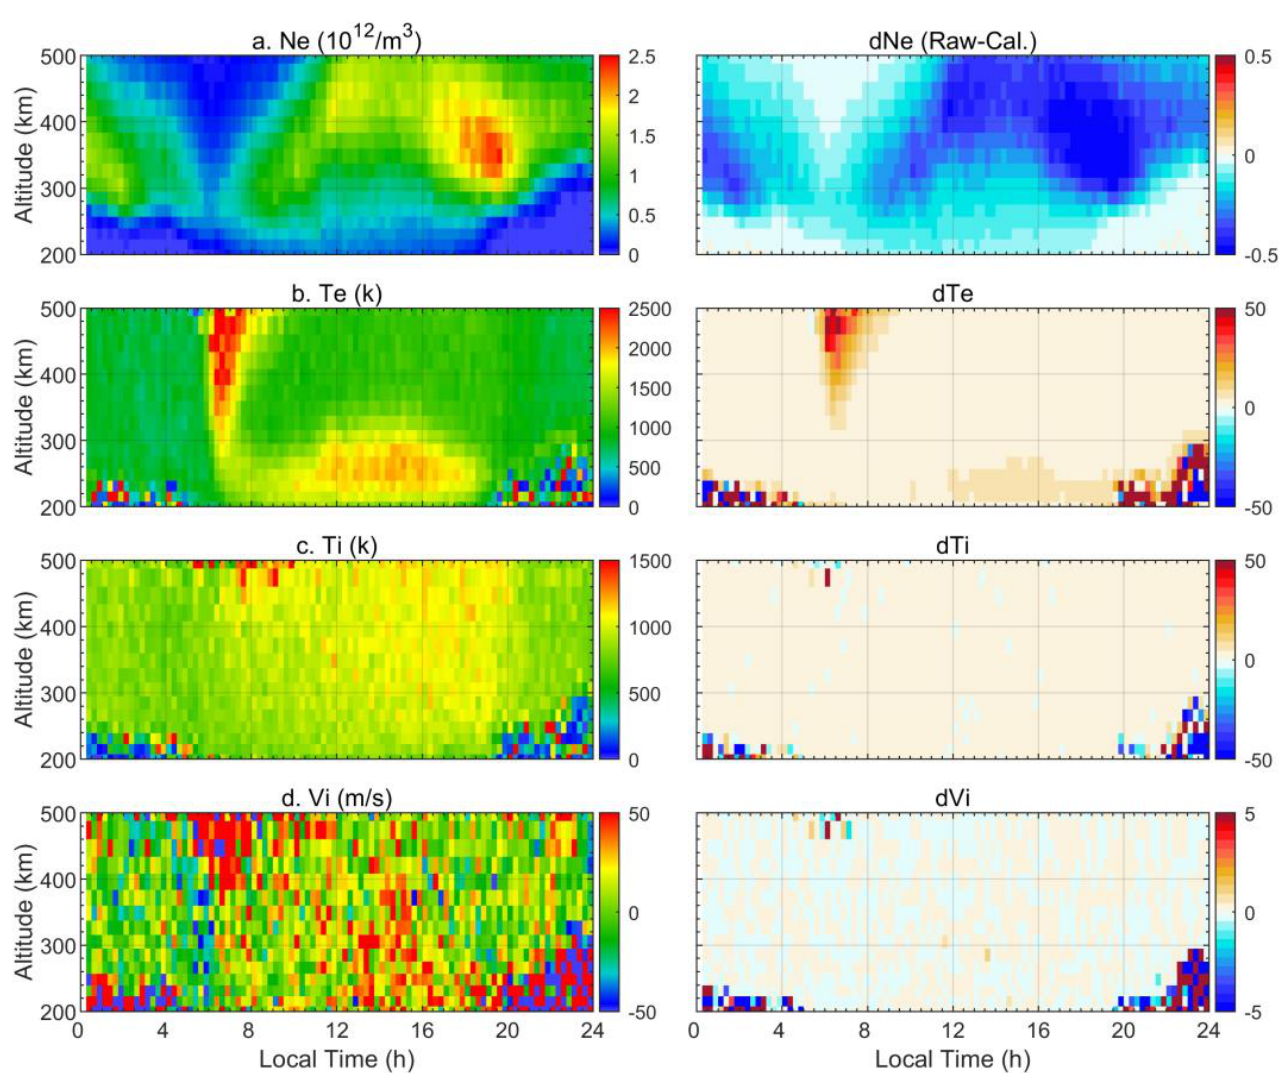
Figure 4. Local time and altitude variations of the retrieved electron density ( a ), electron tempera- ture ( b ), ion temperature ( c ), and line-of-sight ion bulk velocity ( d ) during the entire day of 6 May 2022. The left panels are the results after calibration, while the right panels are the differential results between parameters before-calibration and after-calibration.